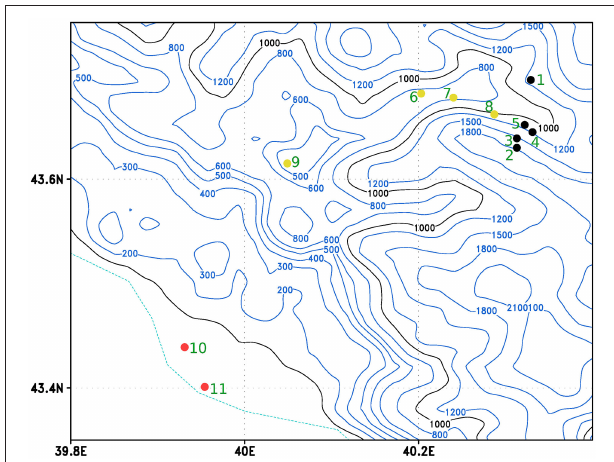
FIGURE 5 | Location of the observation sites. Mountain, valley, and coastal stations are marked with black, yellow, and red dots, respectively. Green numbers refer to the list of stations in Table 3 . The contours represent average orographic height (meters) in Harmonie model with 1.5km grid size, based on SRTM 3 ′′ data. Dashed cyan line on the lower left denotes coastline.